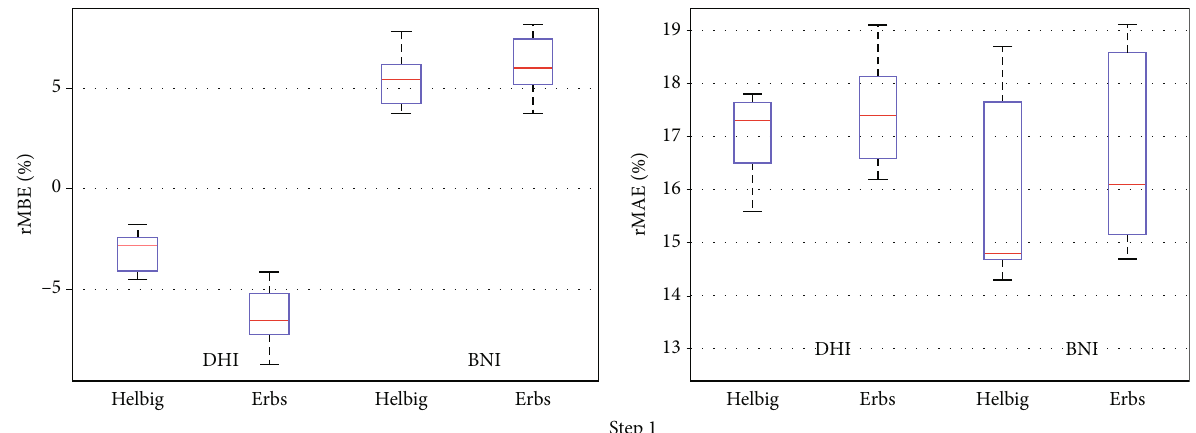
Figure 3: rMBE (left) and rMAE (right) of Helbig and Erbs models to calculate DHI and BNI from GHI measured at SIRTA. Computed data are summarized in Figure 9 of Appendix